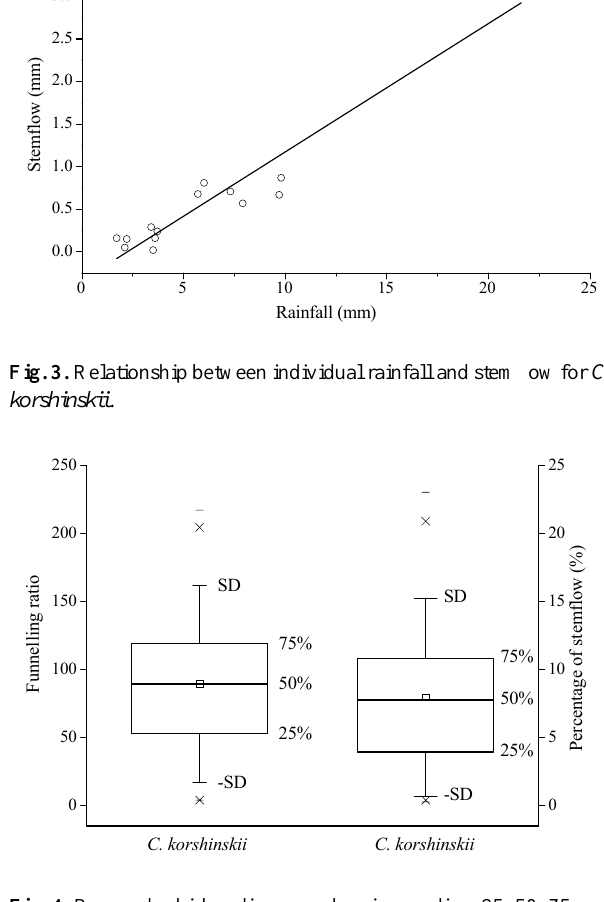
Fig. 4. Box-and-whisker diagrams showing median, 25, 50, 75 percentiles, and standard deviation for individual funneling ratio and stemflow percentage for C. korshinskii . ( □ ) represents mean value, (–) maximum and minimum value and (×) are 1 st and 99 th percentiles.